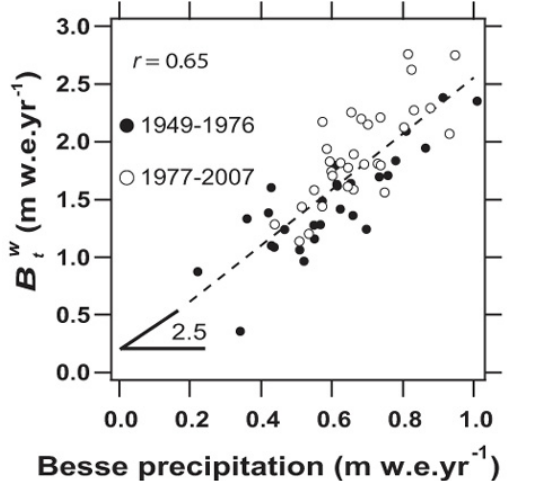
Fig. 6. Glacier-wide winter balance at Sarennes as a function of precipitation recorded at Besse weather station (only for days with precipitation and a temperature below 0 ◦ C at